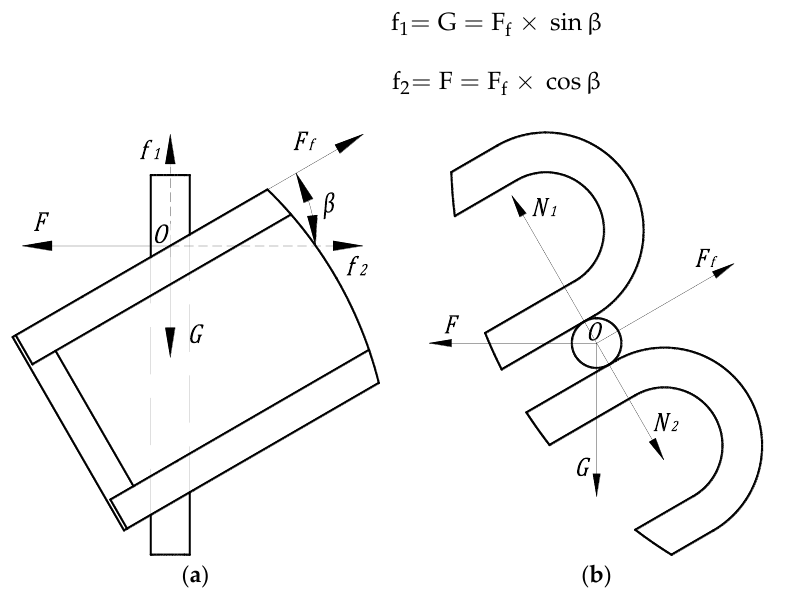
Figure 8. Clamping and conveying force diagram of rape shoot stalks: ( a ) the feeding port; ( b ) the discharge port.